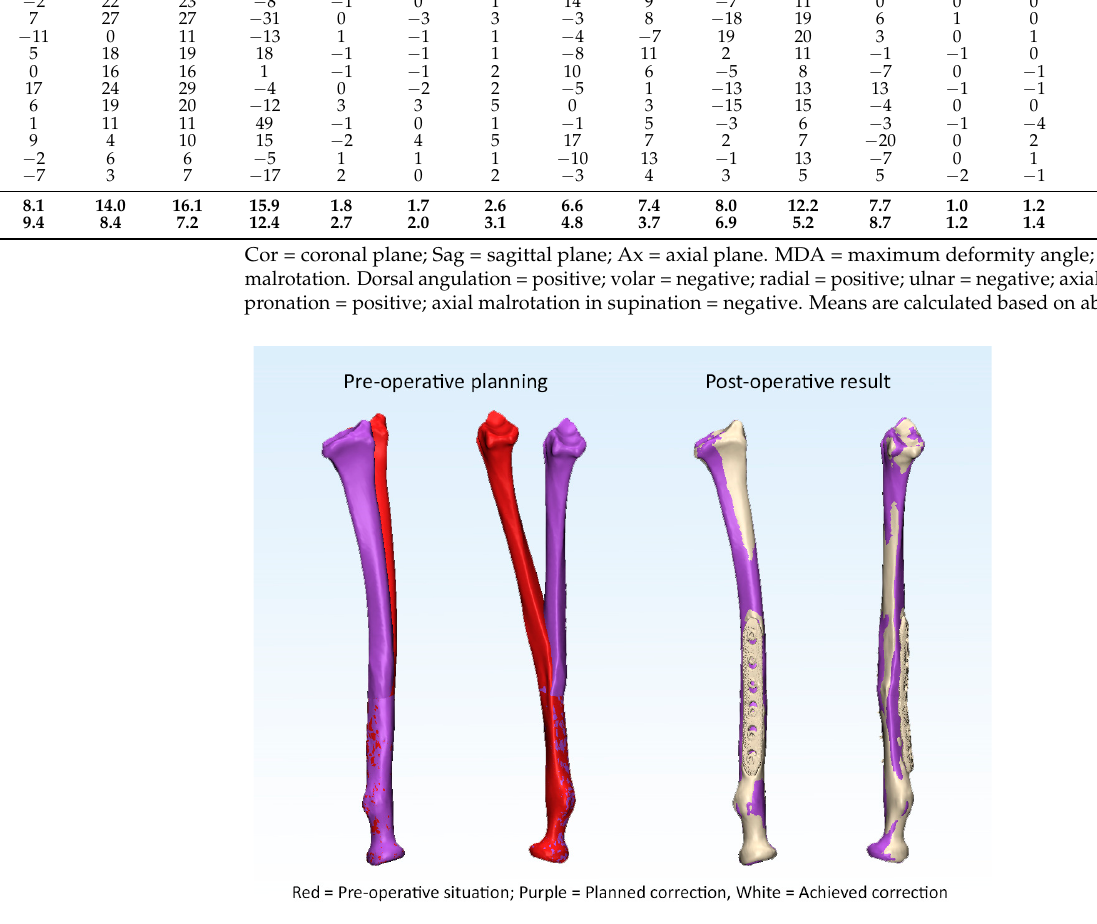
Figure 3. Example of an anatomic correction of the radius.